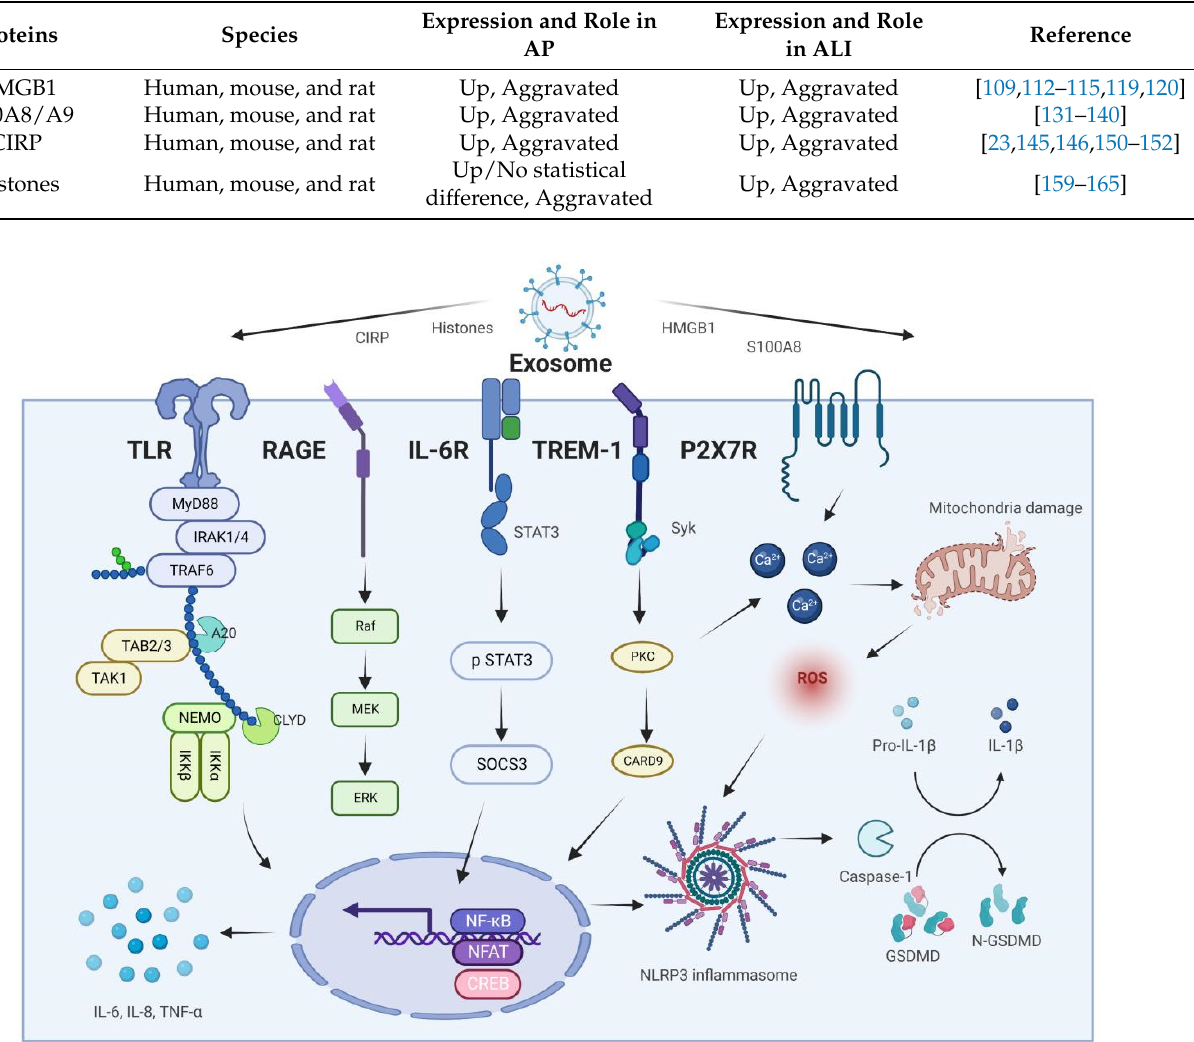
Figure 3. Molecular mechanisms of exosome-specific proteins in AP-associated ALI.